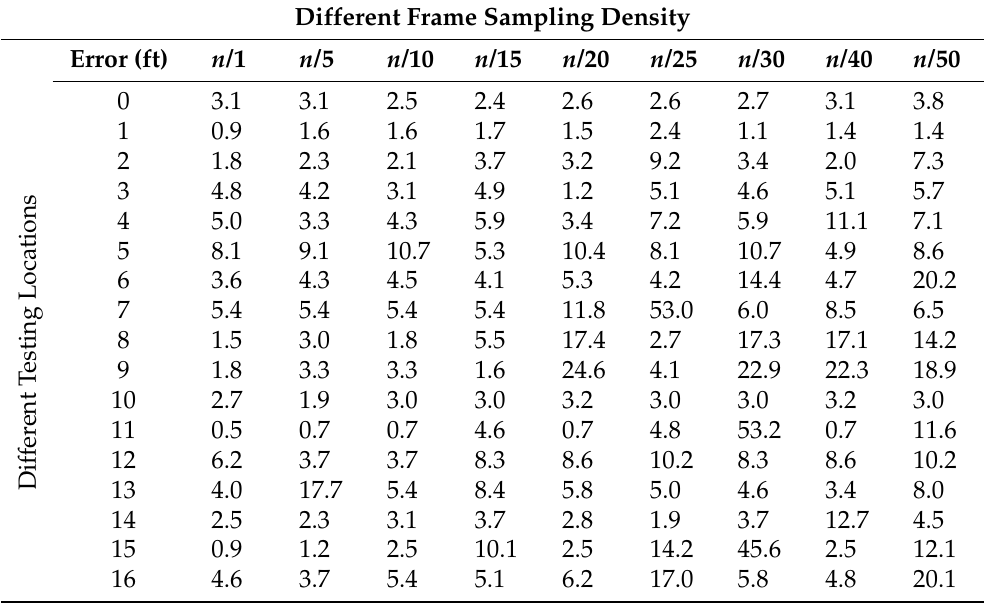
Table 2. Estimated location errors (ft) at 17 testing locations with different frame downsampling rates α ∈ [ 1,5,10,15,20,25,30,40,50 ] on n = 4258 reference images. Different Frame Sampling